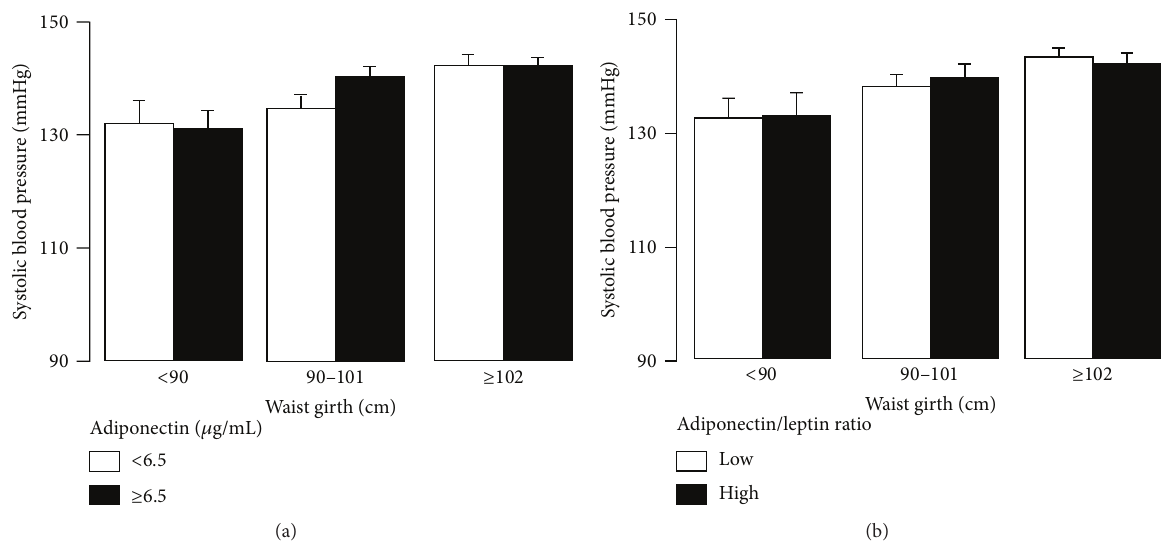
Figure 4: Systolic blood pressure in nonobese, overweight, and obese men was similar in those with low and those with high level of adiponectin (a). There were no significant differences in systolic blood pressure when the men were subgrouped according to the ratio of adiponectin/leptin